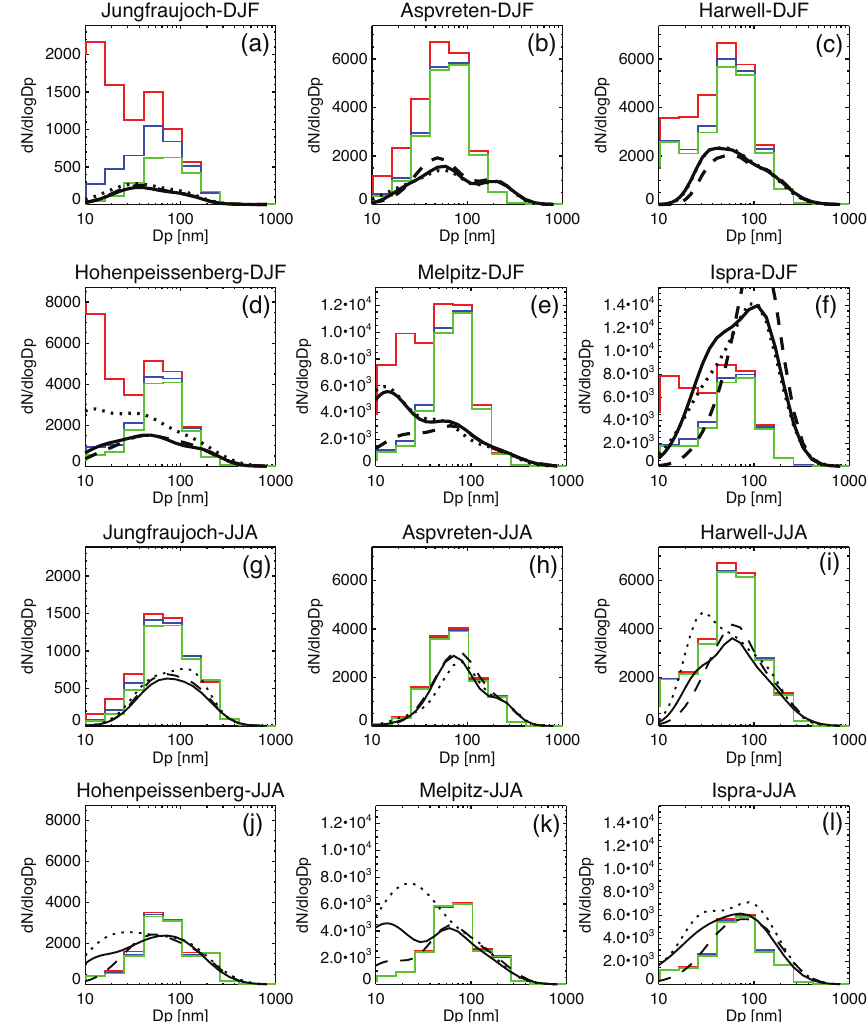
Figure 23. Number size distributions from European sites during winter (DJF; a to f ) and summer (JJA; g to l ) that are obtained from lognormal three-mode fits during morning (black solid), afternoon (black dotted), and night (black dashed). The model results are the seasonal mean, shown in red lines for the BASE run, blue lines for the LowNUC run, and green lines for the NoNUC